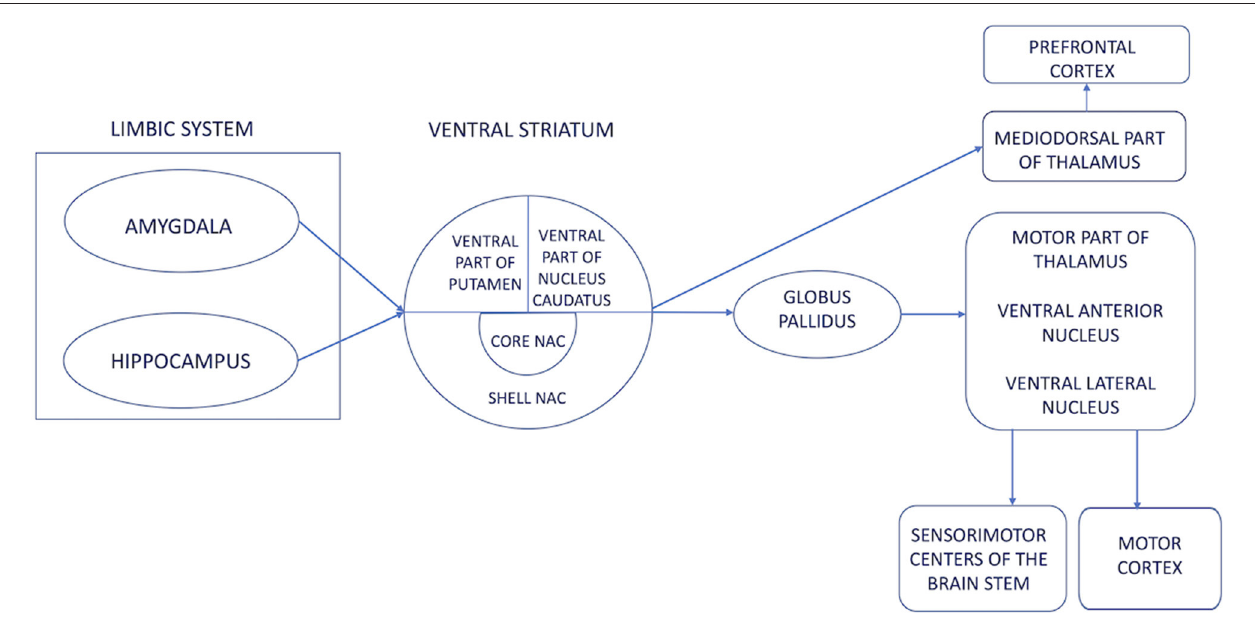
FIGURE 4 | A diagram of the emotional-motor switch illustrating the connections of the limbic system with the motor cortex, i.e., the essence of aggressive and self-destructive behaviors. The ventral striatum is an area where the authors modulated pathological impulses coming from the limbic system to produce aggressive and self-destructive